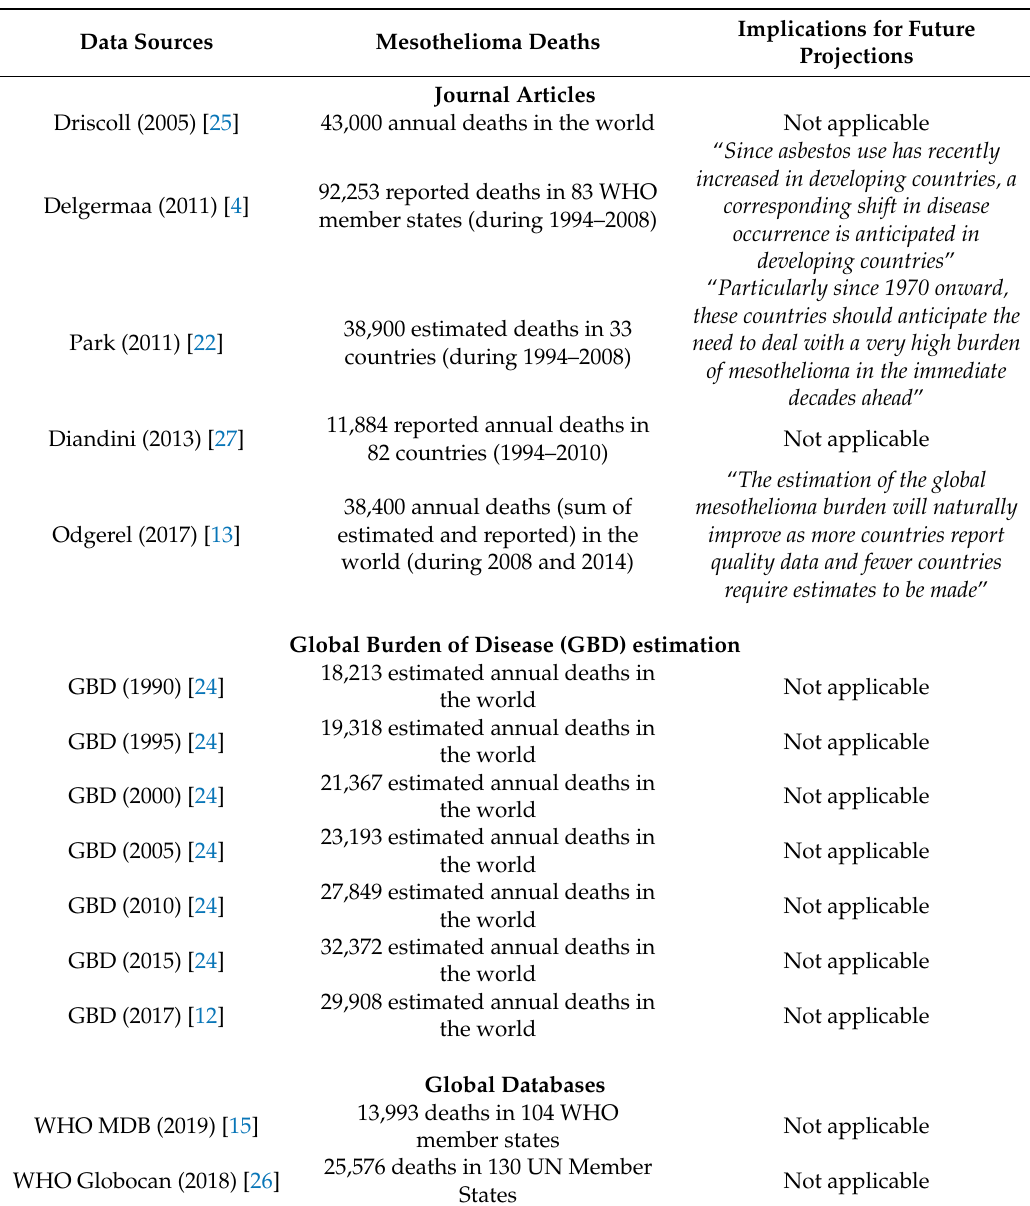
Table 1. Data sources for estimated numbers of global mesothelioma